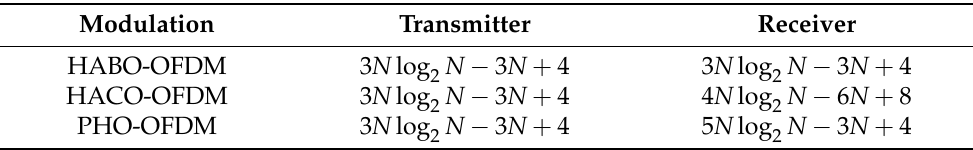
Table 1. Comparison of the complexity of the transmitter and receiver of different optical OFDM